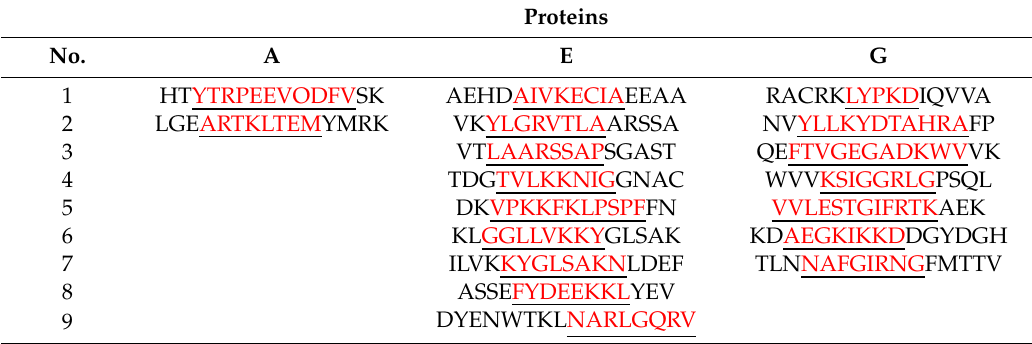
Table 1. The amino acid sequences containing the immunogenic epitopes (red underlined) of two ‡ epitopes of A, ten epitopes of E, and seven epitopes of G (AEG::SOE2) protein . Proteins No. A E G 1 HTYTRPEEVODFVSK